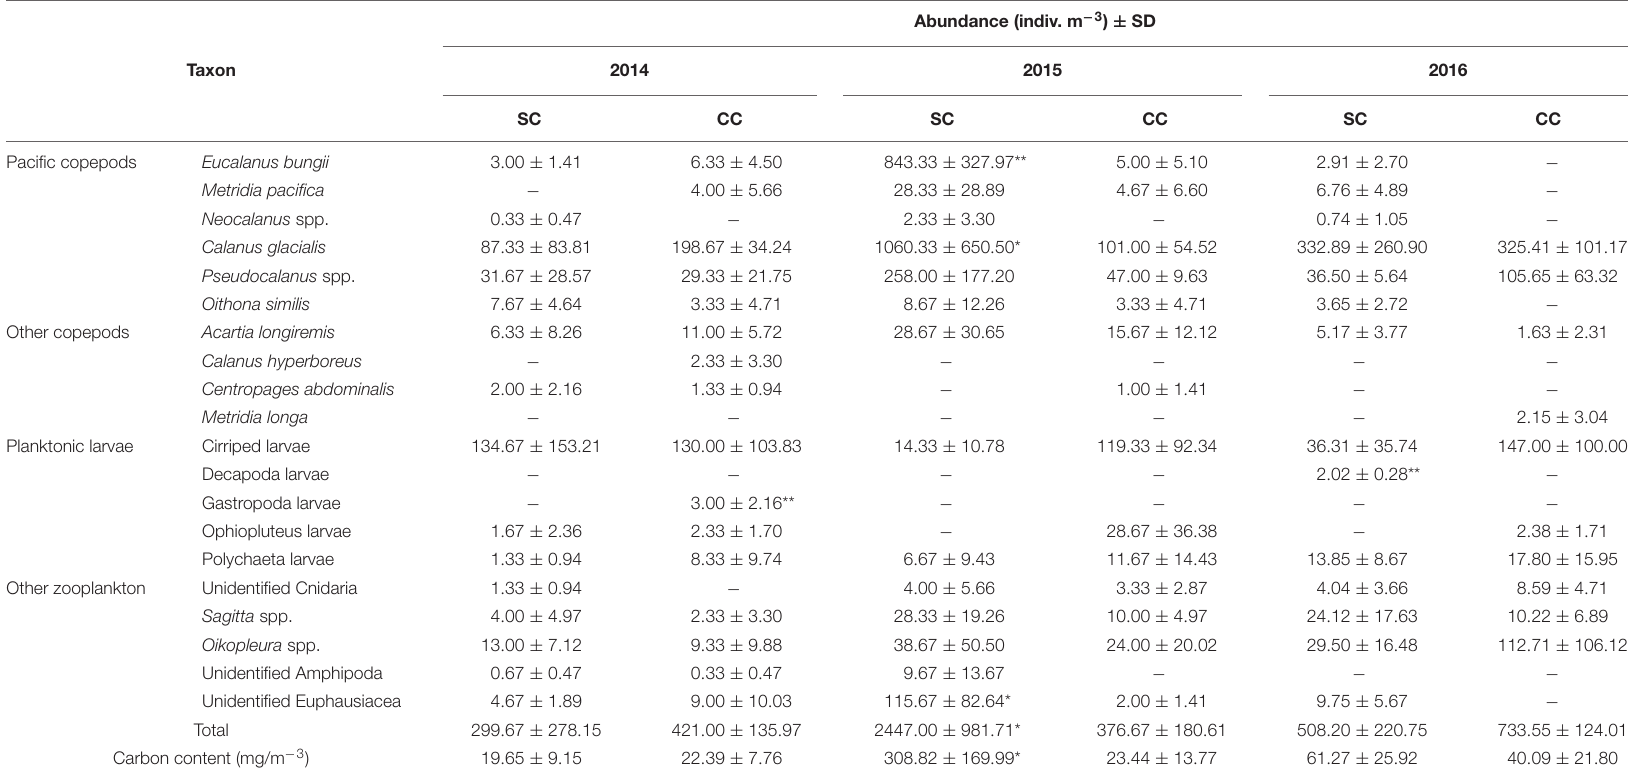
TABLE 2 | Summary of mean abundance (indiv. m − 3 ) ± SD for dominant taxa in southern Chukchi Sea (SC) and central Chukchi Sea